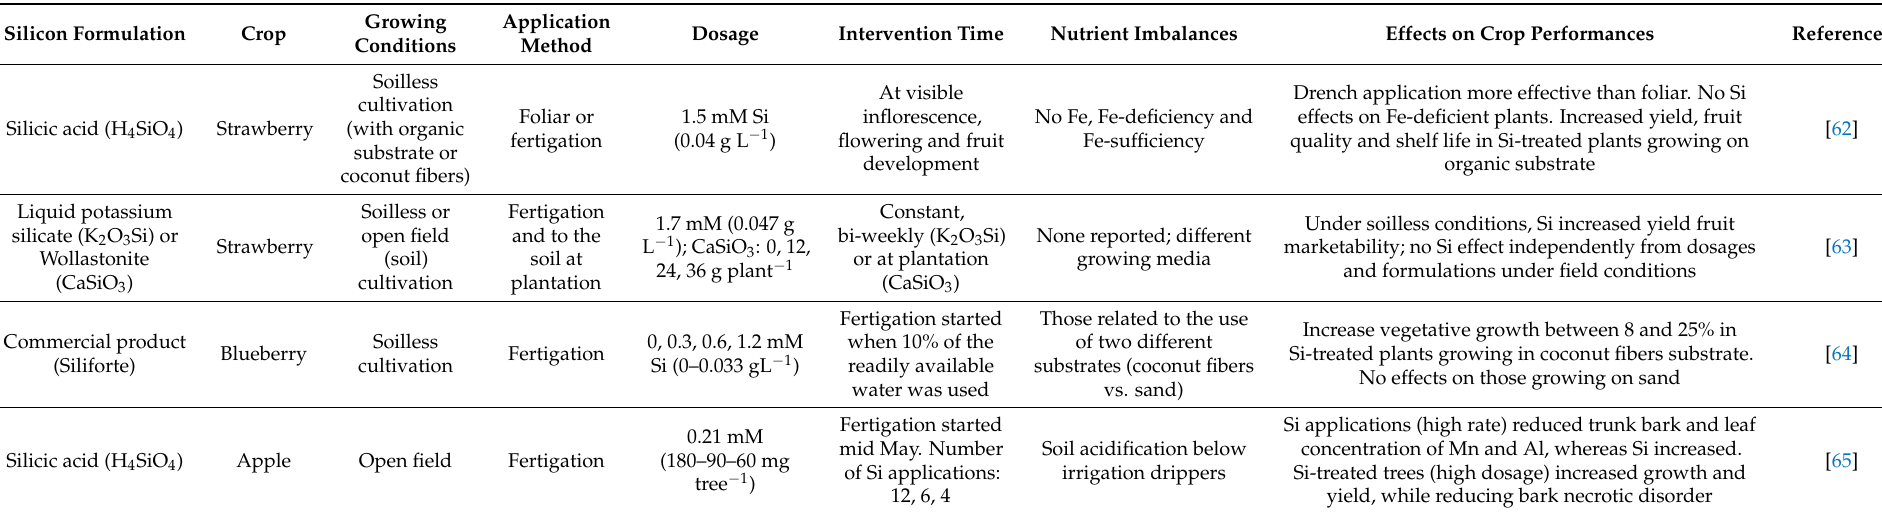
Table 5. Silicon application methods to contrast nutrient imbalances and to increase Si concentration in plant